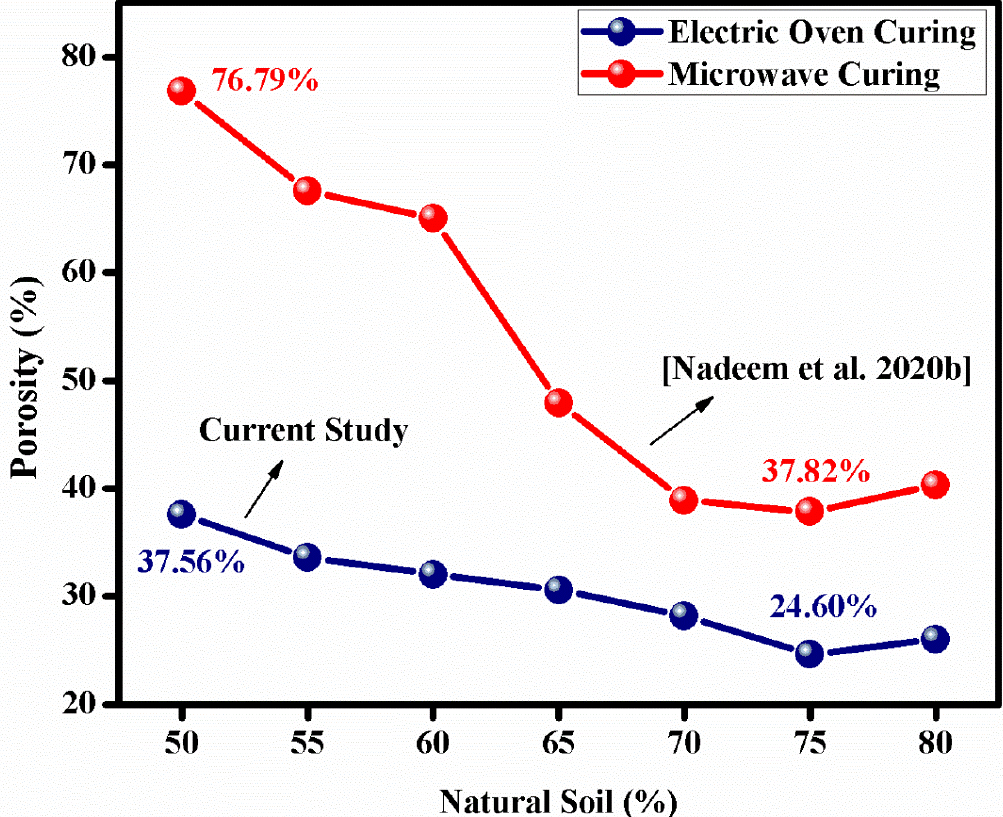
Figure 3. Percentage of porosity as a function of NS weight fraction—comparison of oven heating vs. microwave curing [8].